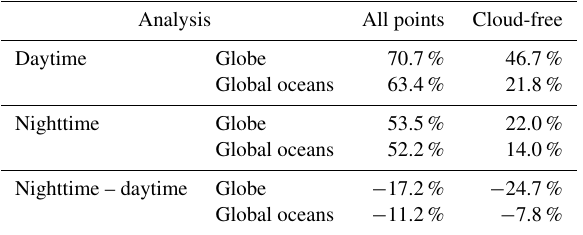
Table 4. All-RFV CALIOP occurrence frequencies for 2 months (January and February 2008) from various analyses using daytime and nighttime data, as well as their corresponding absolute differ-